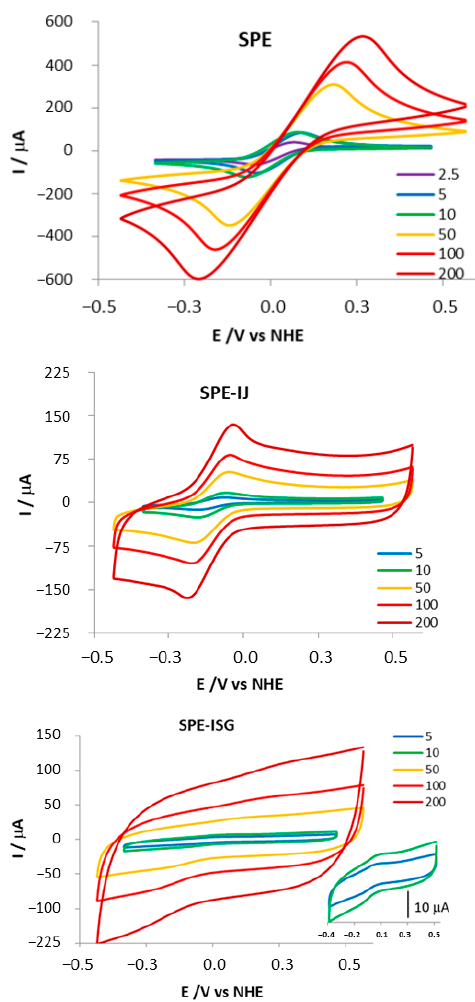
Figure 3. Representative 3rd cycles of the cyclic voltammograms attained with 10 × 10 − 3 mol·dm − 3 Fe(CN) 63 − /Fe(CN) 64 − in 1 mol.dm − 3 KNO 3 at various scan rates for SPE, SPE-IJ and SPE-ISG (inset is a magnification of the lower scan rates, in mV·s − 1 ), respectively. Table 1. Formal reduction potentials, peak separation and ratio of the anodic and cathodic current peaks as a function of scan rate for the Fe(CN) 63 − /Fe(CN) 64 − redox couple in SPE, SPE-IJ and SPE-ISG. Values are averages of the data obtained from all 3 cycles, and respective standard deviation.